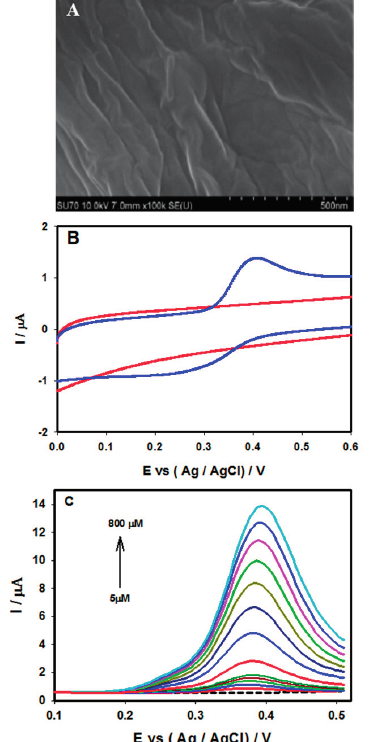
Figure 3. ( A ) FE-SEM images of electrochemically reduced grapheme oxide (rGO) on the GCE surface; ( B ) CVs recorded at the rGO/GCE in the absence (red solid line), and presence of 50 µM acetaminophen (blue solid line) in 0.1 M PBS (pH 7.4) at a scan rate of 20 mV/s; ( C ) DPVs of the rGO/GCE recorded in 0.1 M PBS (pH 7.4) containing different acetaminophen concentrations (5 µM to 800 µM). Figure 3A and 3B are reproduced with permission from [26]. Copyright 2015